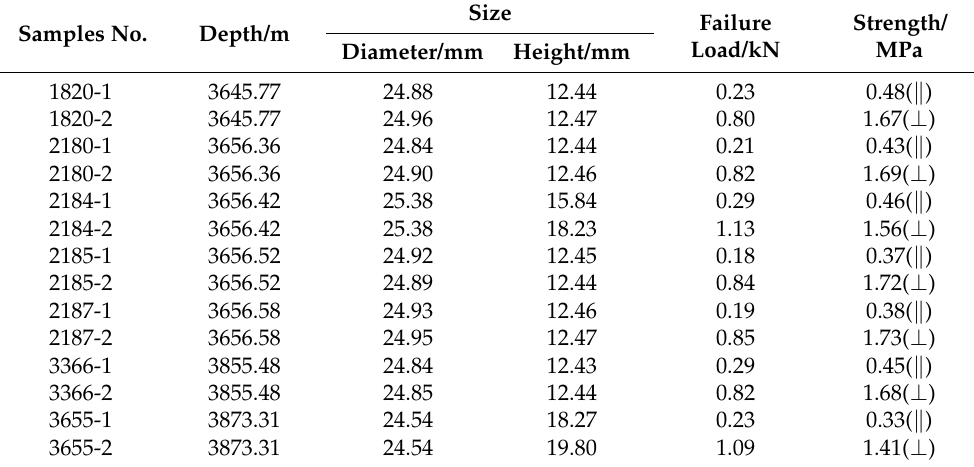
Table 1. Brazil splitting tests